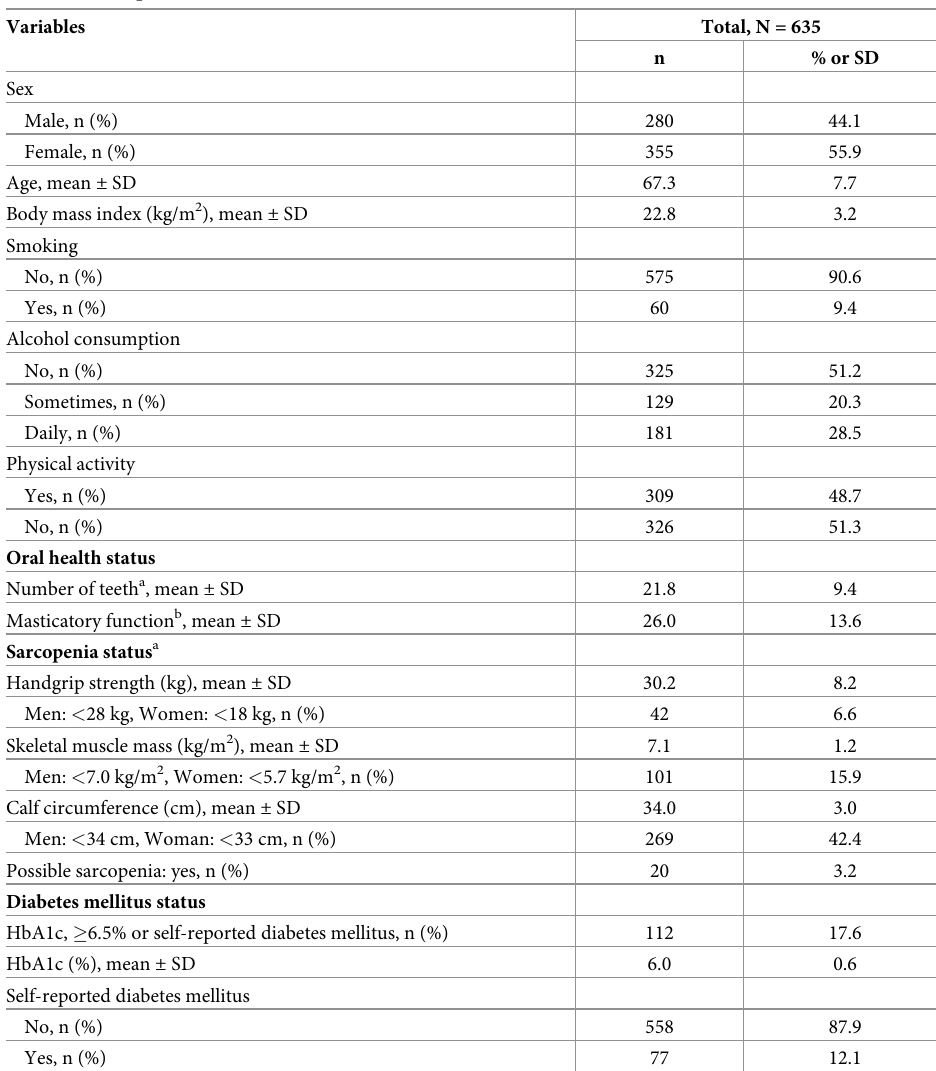
Table 1. Participants’